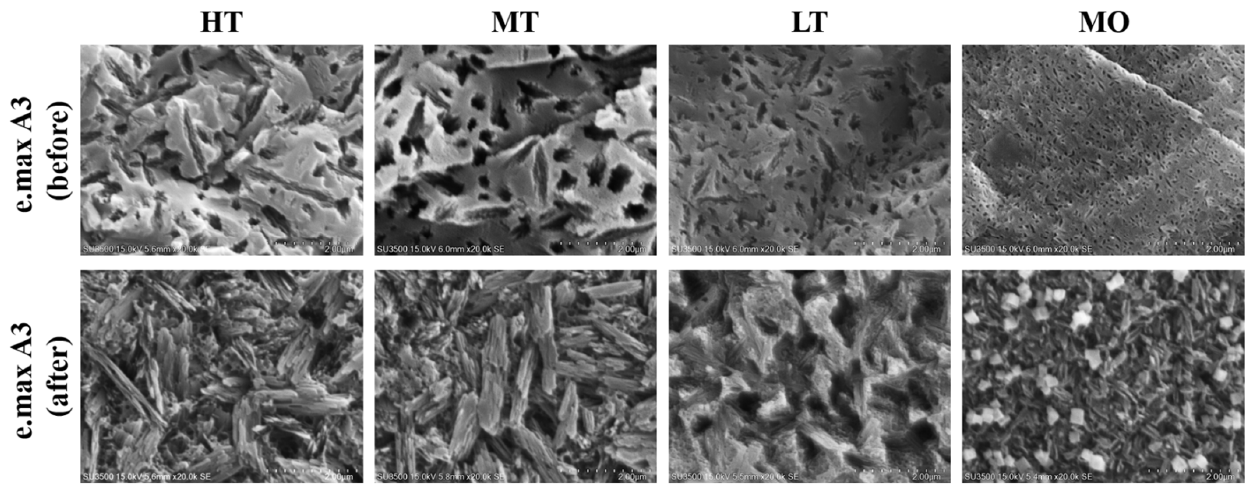
Figure 6. SEM images showing the microstructure of the e.max CAD ceramics in four different translucency extents.